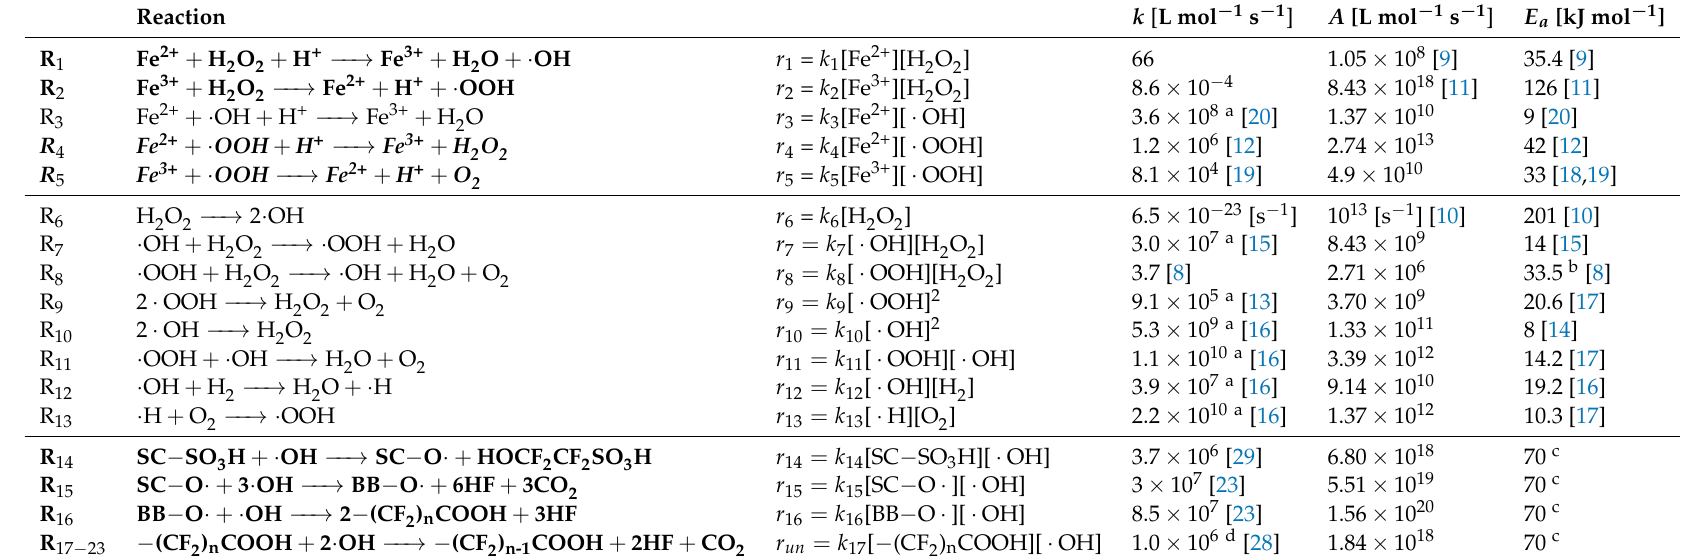
a Rate constants were recalculated for T = 298.15K. b Activation energy is estimated between 6 to 10 kcal mol − 1 . c Average activation energy found in various degradation experiments [27,41]. d Upper limit for the attack of · OH on CF 3 COOH